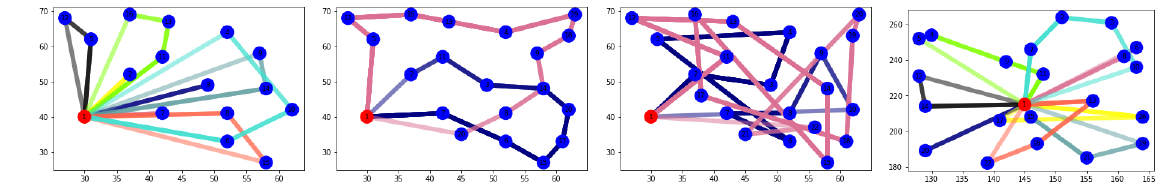
Figure 4. Optimal routes for instances in table